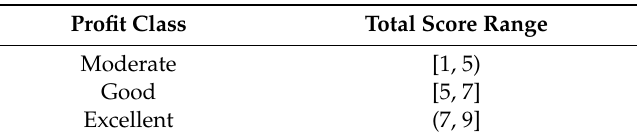
Table 8. Fuzzy scorings